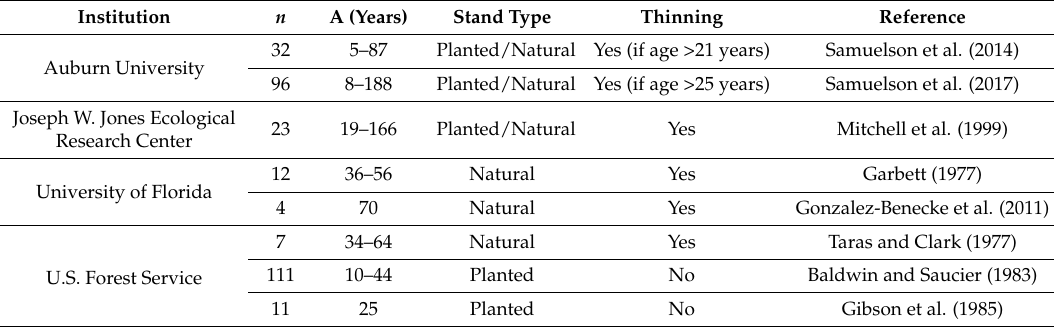
Table 1. Summary biomass measurement per